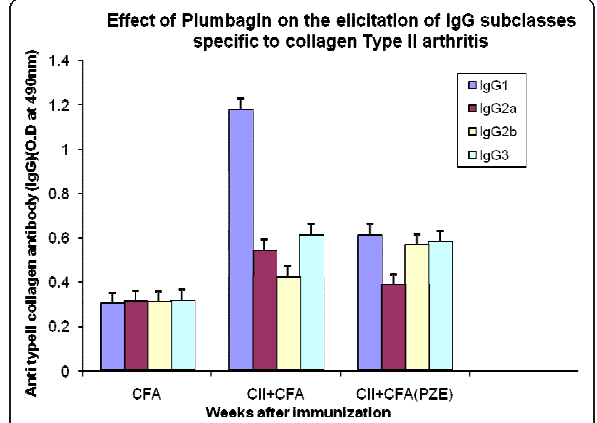
Figure 2 Effect of Plumbagin on elicitation of Ig G subclasses specific to collagen type II arthritis . Two groups of DBA/1 mice were immunized with 0.1 ml of bovine type II collagen along with CFA intradermally at the base of the tail. Booster dose was given on day 21. Test group was treated with Plumbagin. Control mice were treated with olive oil alone. Retroorbital sera were collected at 3, 5, 7 week intervals after primary immunization for the estimation of IgG subclasses by ELISA. p-value ≤ 0.05 was significant.